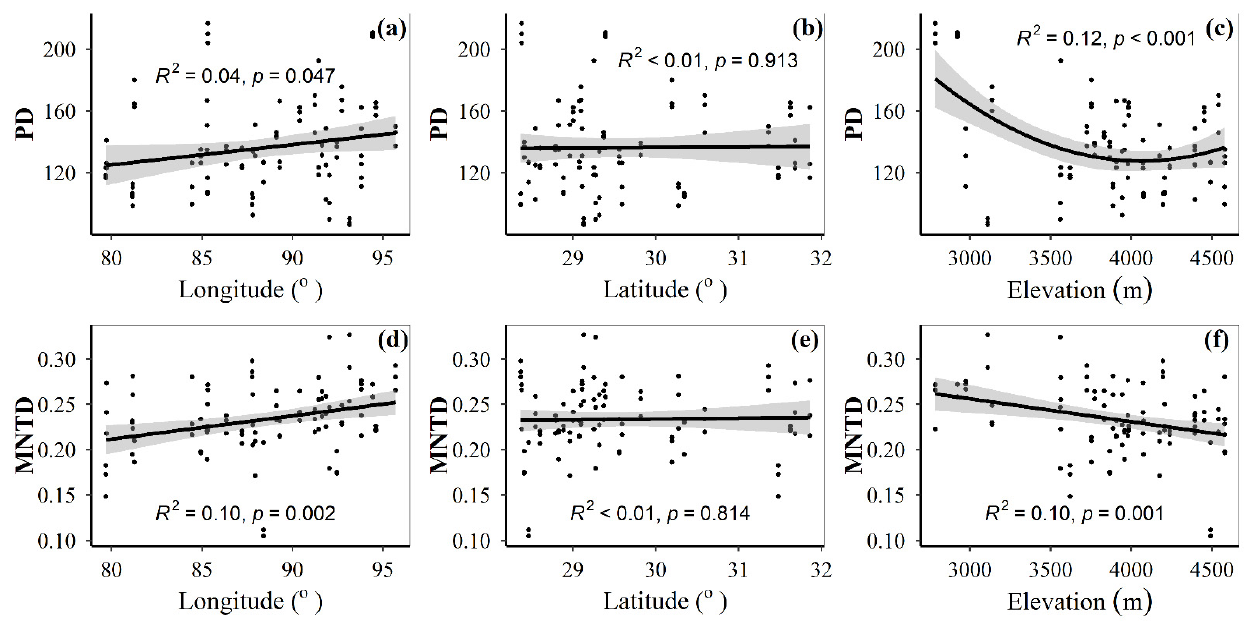
Figure A14. Relationships between phylogenetic α -diversity and geographic variables (longitude, latitude, and elevation) at 10–20 cm depth. ( a – c ) phylogenetic diversity (PD), and ( d – f ) mean nearest taxon distance (MNTD).